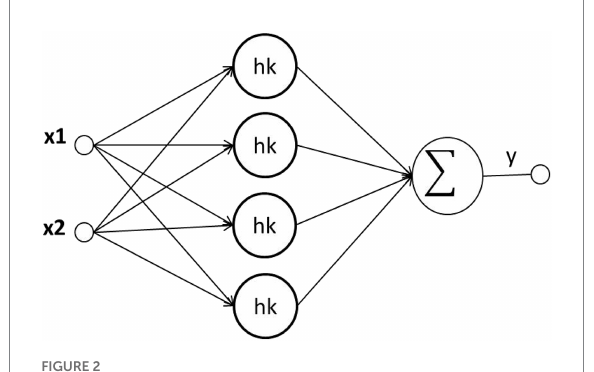
FIGURE 2 Schematic diagram of RBFNN